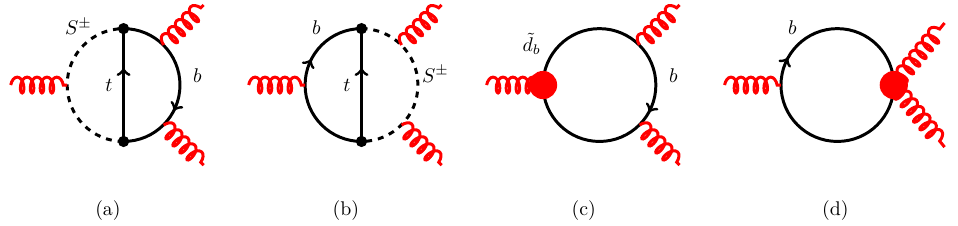
Figure 6 . Charged scalar contributions to the Weinberg operator. Below the top quark mass scale, diagrams (a) and (b) are accounted for through the effective operators of the bottom quark, depicted as red circles in diagrams (c) and (d). These induce a threshold correction to the Weinberg operator at the bottom quark mass scale, as shown in eq.